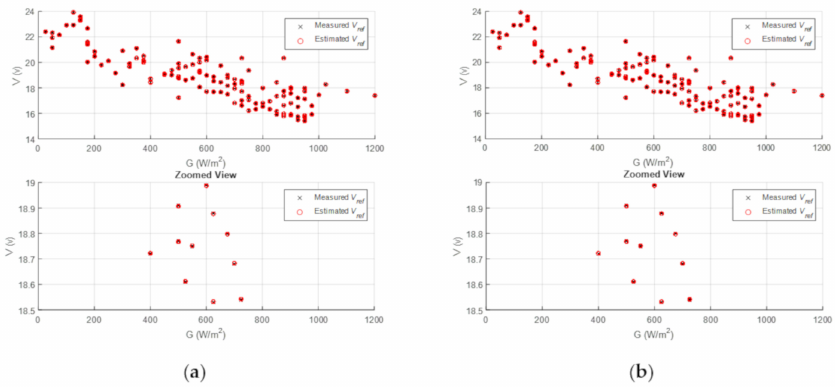
Figure 9. Predicted and measured V ref for di ff erent irradiation levels using: ( a ) SVR; ( b )